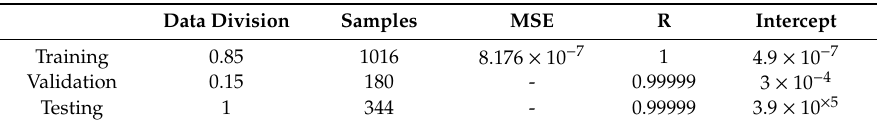
Table 2. Parameters of optimized ANN and results of the training network process, validation and testing of the RBF-ANN model. Data Division Samples MSE Figure 5. ( a ) Comparison of the training target with simulated training outputs for E ′ ( T, f ); ( b ) Comparison of the training target with simulated training outputs for E’’ ( T , f ); ( c ) Comparison of the training target with simulated training outputs for tan δ ( T , f